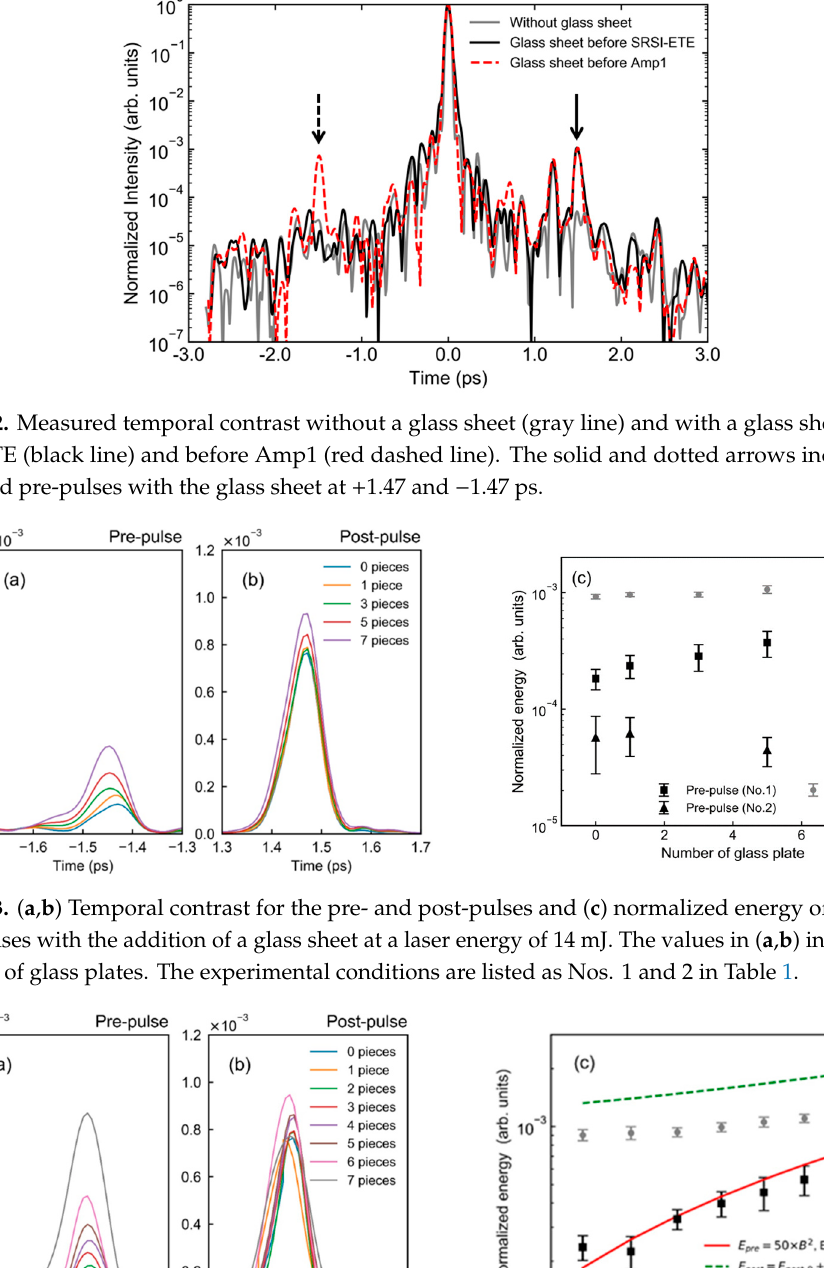
Figure 2. Measured temporal contrast without a glass sheet (gray line) and with a glass sheet before SRSI ‐ ETE (black line) and before Amp1 (red dashed line). The solid and dotted arrows indicate the post ‐ and pre ‐ pulses with the glass sheet at +1.47 and − 1.47 ps.